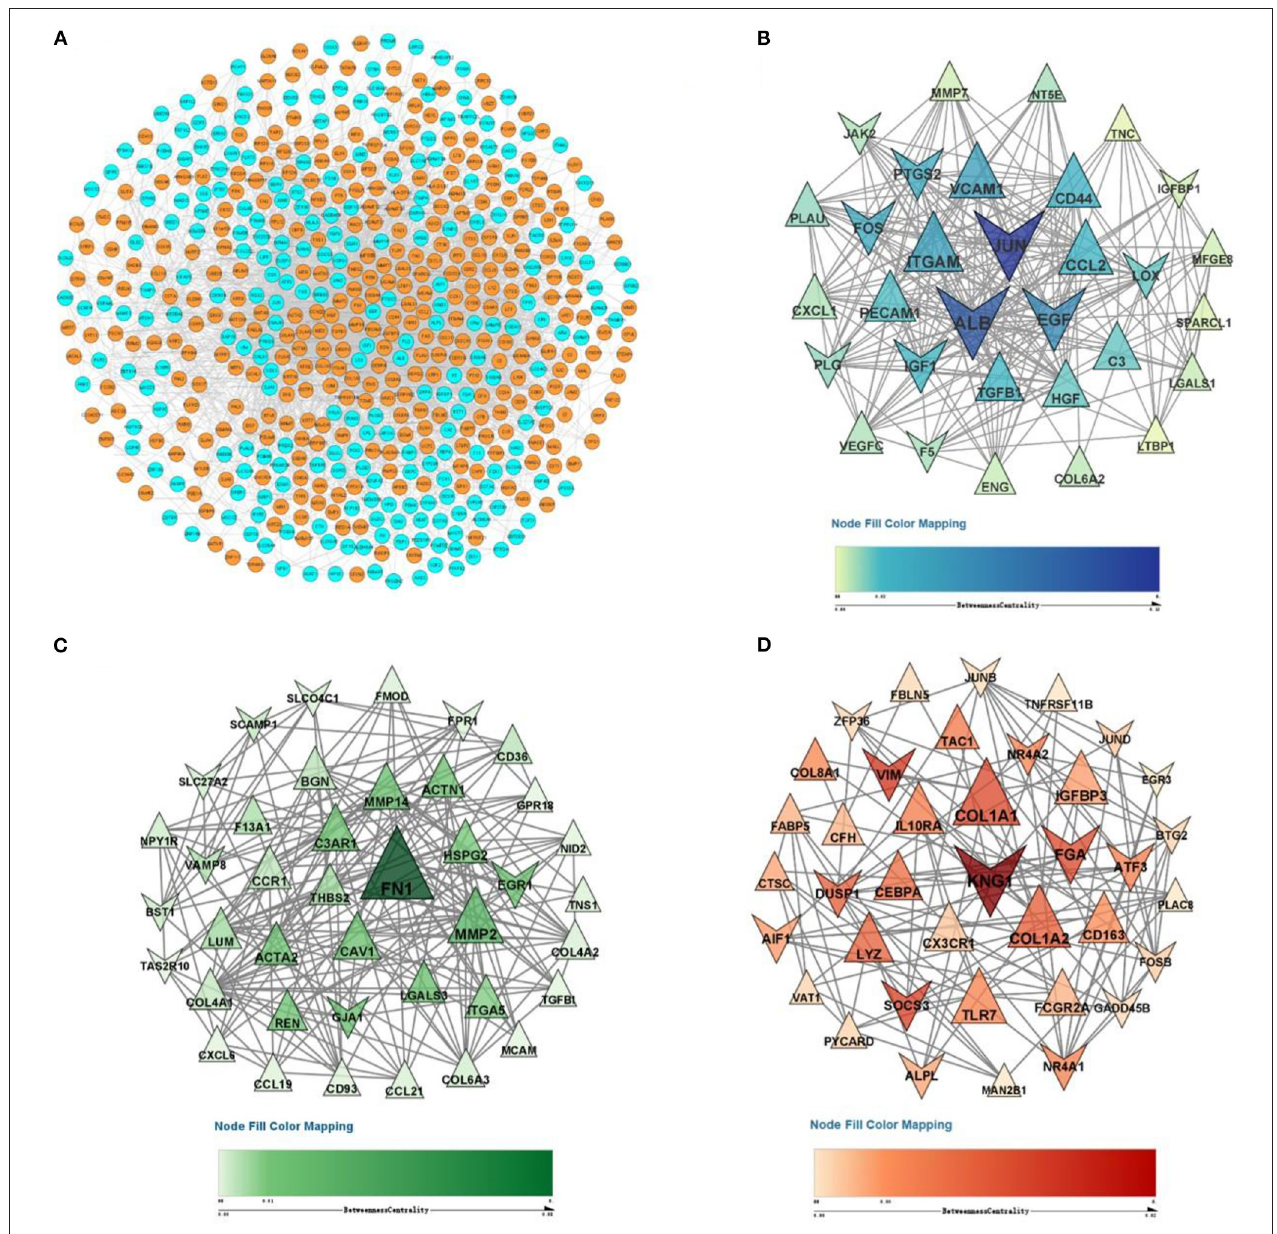
FIGURE 4 | PPI network and three significant modules of DEGs. (A) PPI network of DEGs created by merging the STRING, MINT, IntAct, and Reactome databases. The orange purple nodes represent upregulated DEGs, and blue nodes represent downregulated DEGs. A total of 578 DEGs formed a PPI network consisting of 557 nodes and 3,882 edges. (B) The most significant module identified by MCODE (score 10.051). (D) The third most significant module identified by MCODE (score =